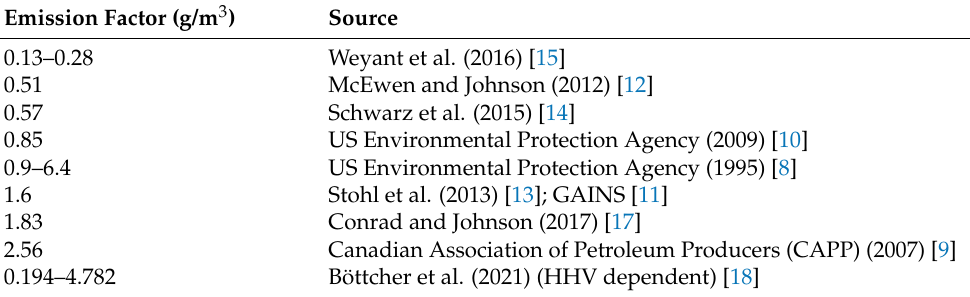
Table 1. Black carbon (BC) emission factors from gas flaring in previous